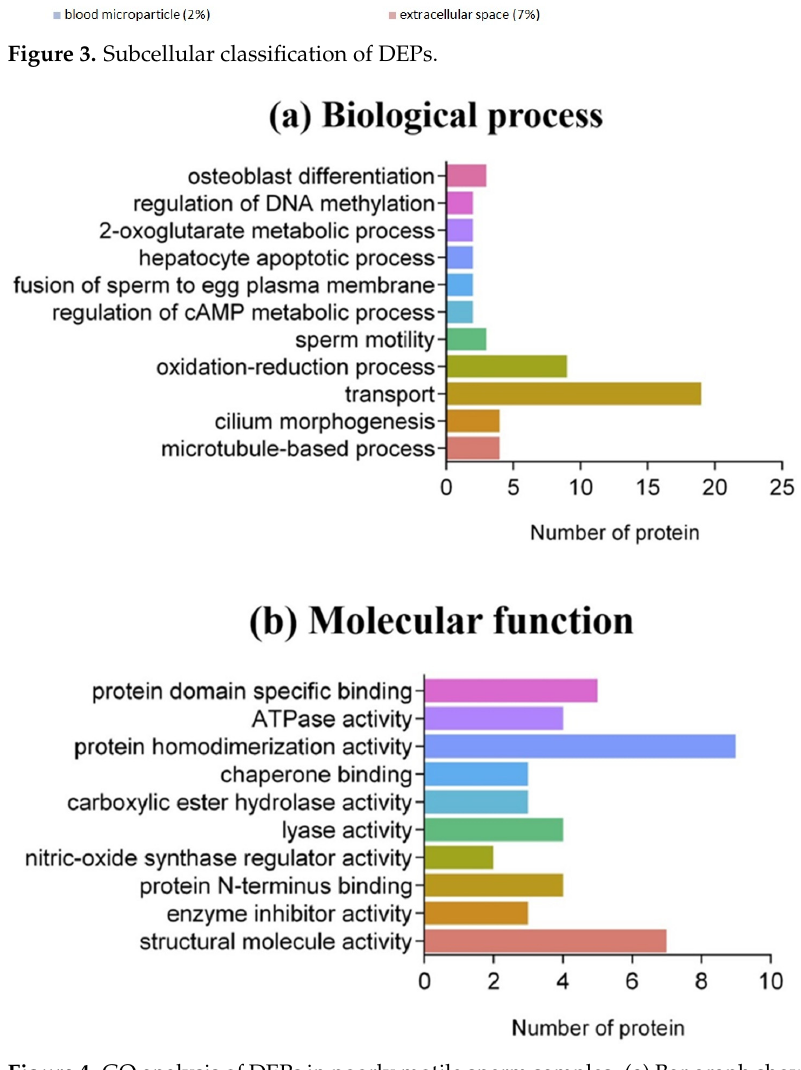
Figure 4. GO analysis of DEPs in poorly motile sperm samples. ( a ) Bar graph showing the numbers of proteins involved in biological processes; ( b ) bar diagram showing the numbers of proteins involved in molecular functions.